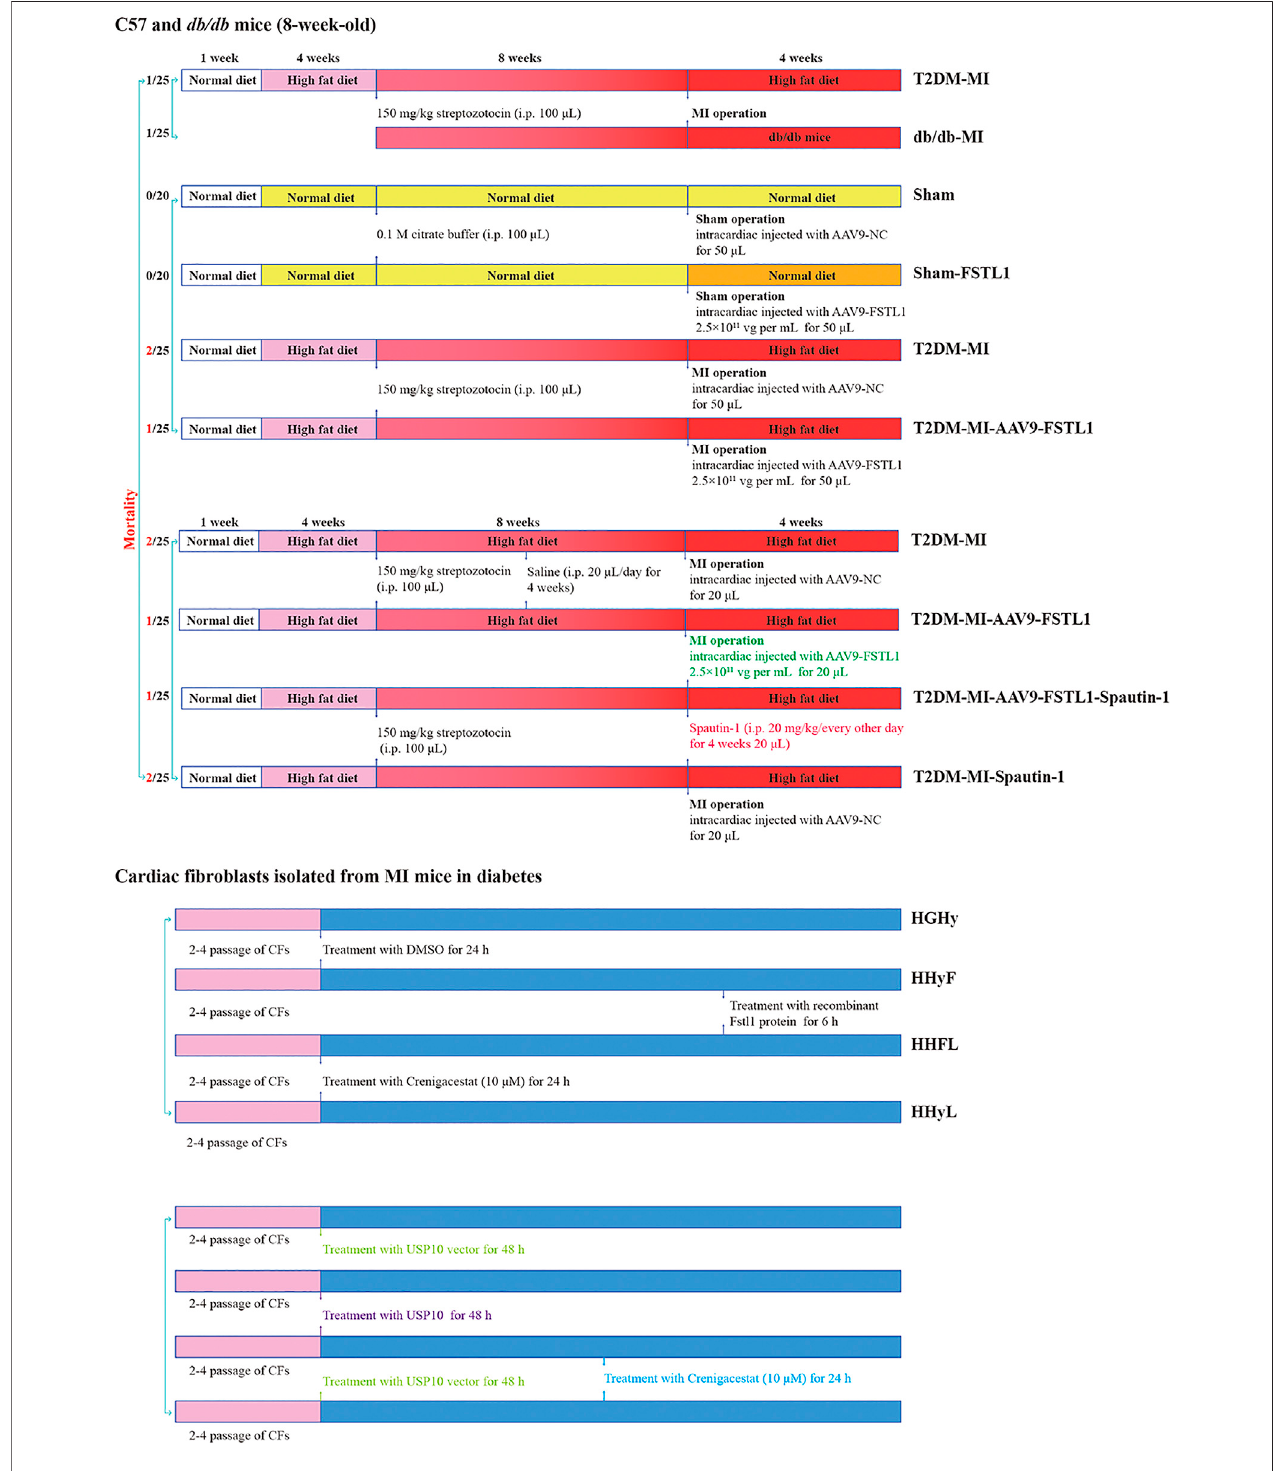
FIGURE 1 | Protocol for in vivo and in vitro experiments and animal mortality for each group.